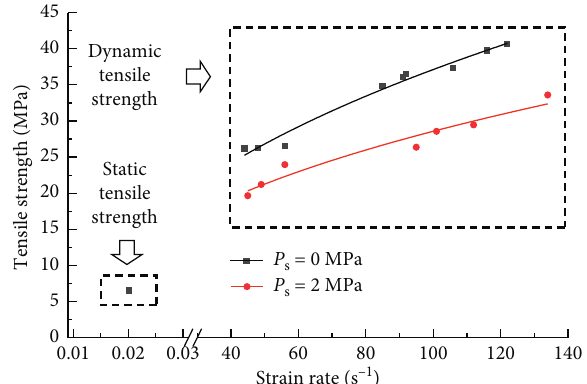
Figure 6: Dynamic splitting tensile stress-strain curves of the disk specimen.